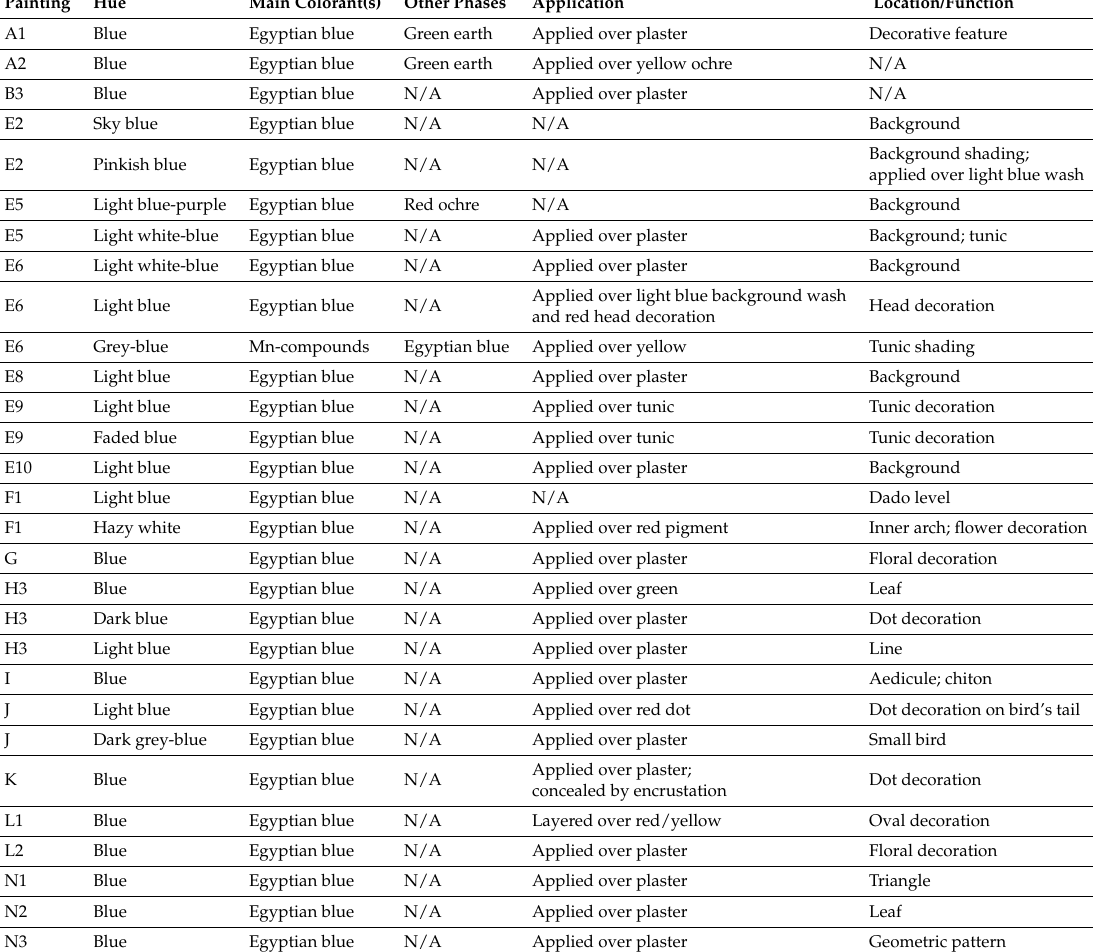
Table A1. Detailed list of the identification and application methodology of Egyptian blue in the Cypriot wall